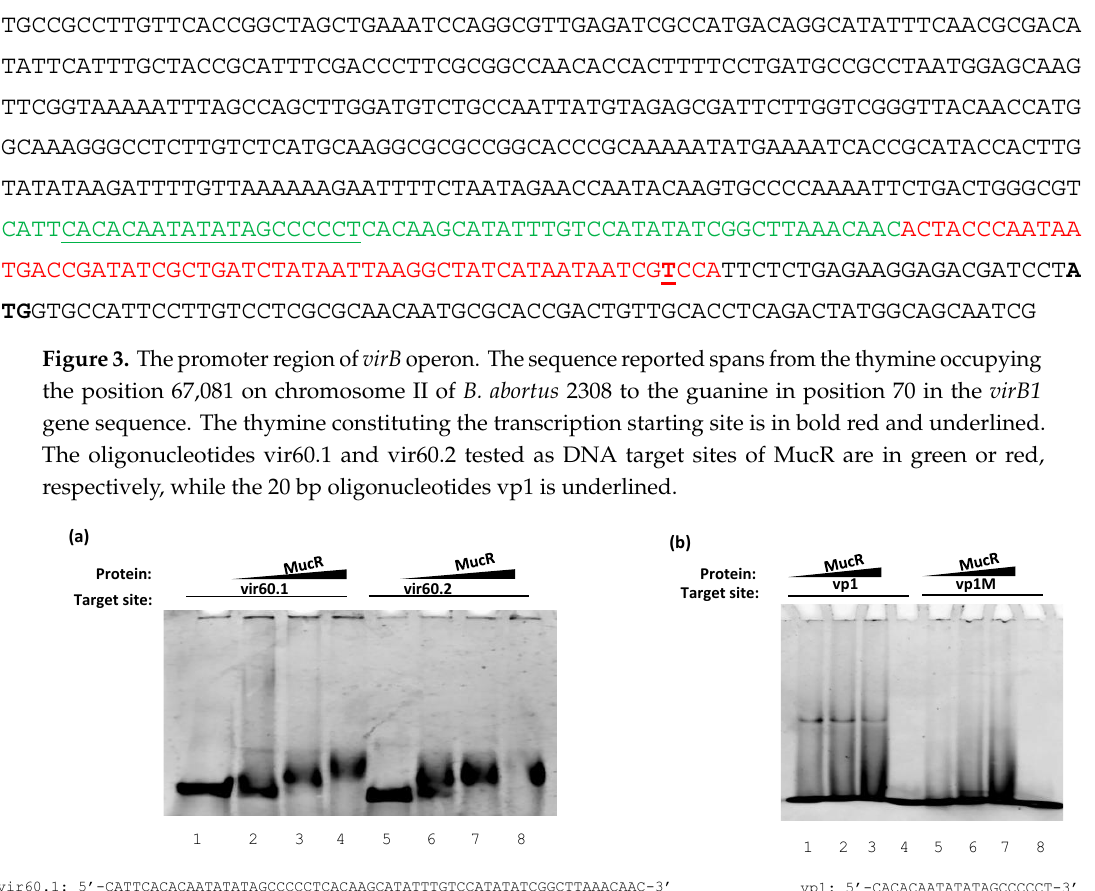
vir60.1: 5’-CATTCACACAATATATAGCCCCCTCACAAGCATATTTGTCCATATATCGGCTTAAACAAC-3’ vir60.2: 5’-ACTACCCAATAATGACCGATATCGCTGATCTATAATTAAGGCTATCATAATAATCGTCCA-3’ Figure 4. MucR binds the virB operon promoter. EMSA of MucR with ( a ) the 60 bp oligonucleotides vir60.1 and vir60.2, and ( b ) with the 20 bp oligonucleotides vp1 and vp1M. In ( a – b ) the single-stranded sequenceofthedouble-strandedoligonucleotidestestedastargetsitesofMucRarereported. TheAT-rich region containing T–A steps are underlined. The growing amount of protein used is reported on the top of the lanes. In panel ( a ), lane 1 shows the sample containing only vir60.1 and lane 5 the sample containing only virB60.2. In panel ( b ), lane 4 shows the sample containing only vp1 and lane 8 the sample containing only